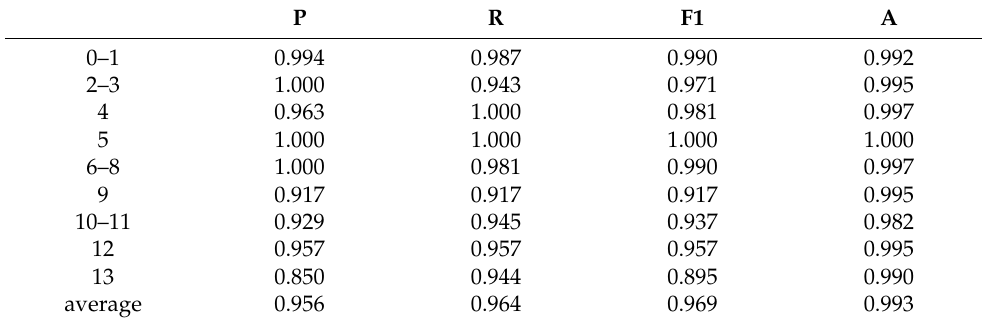
Table 2. Evaluation indexes of confusion matrix.